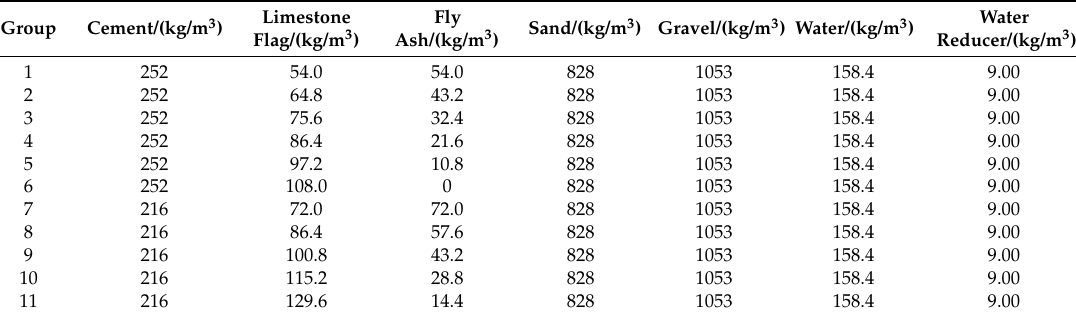
Table 1. Mix properties of green concrete.